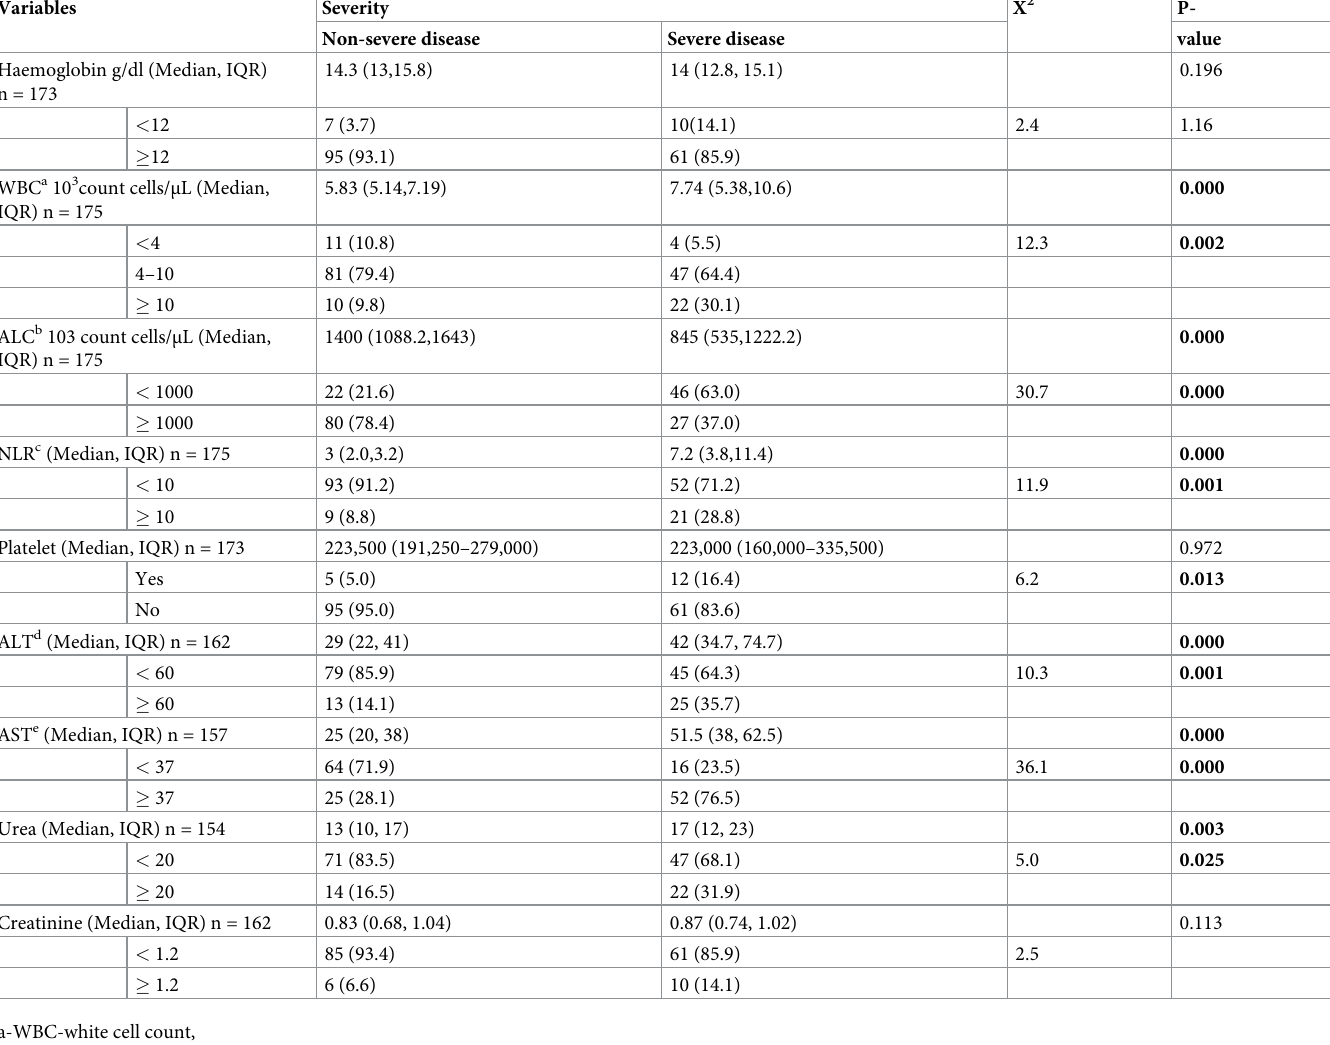
Table 4. Distribution of laboratory values and disease severity of study